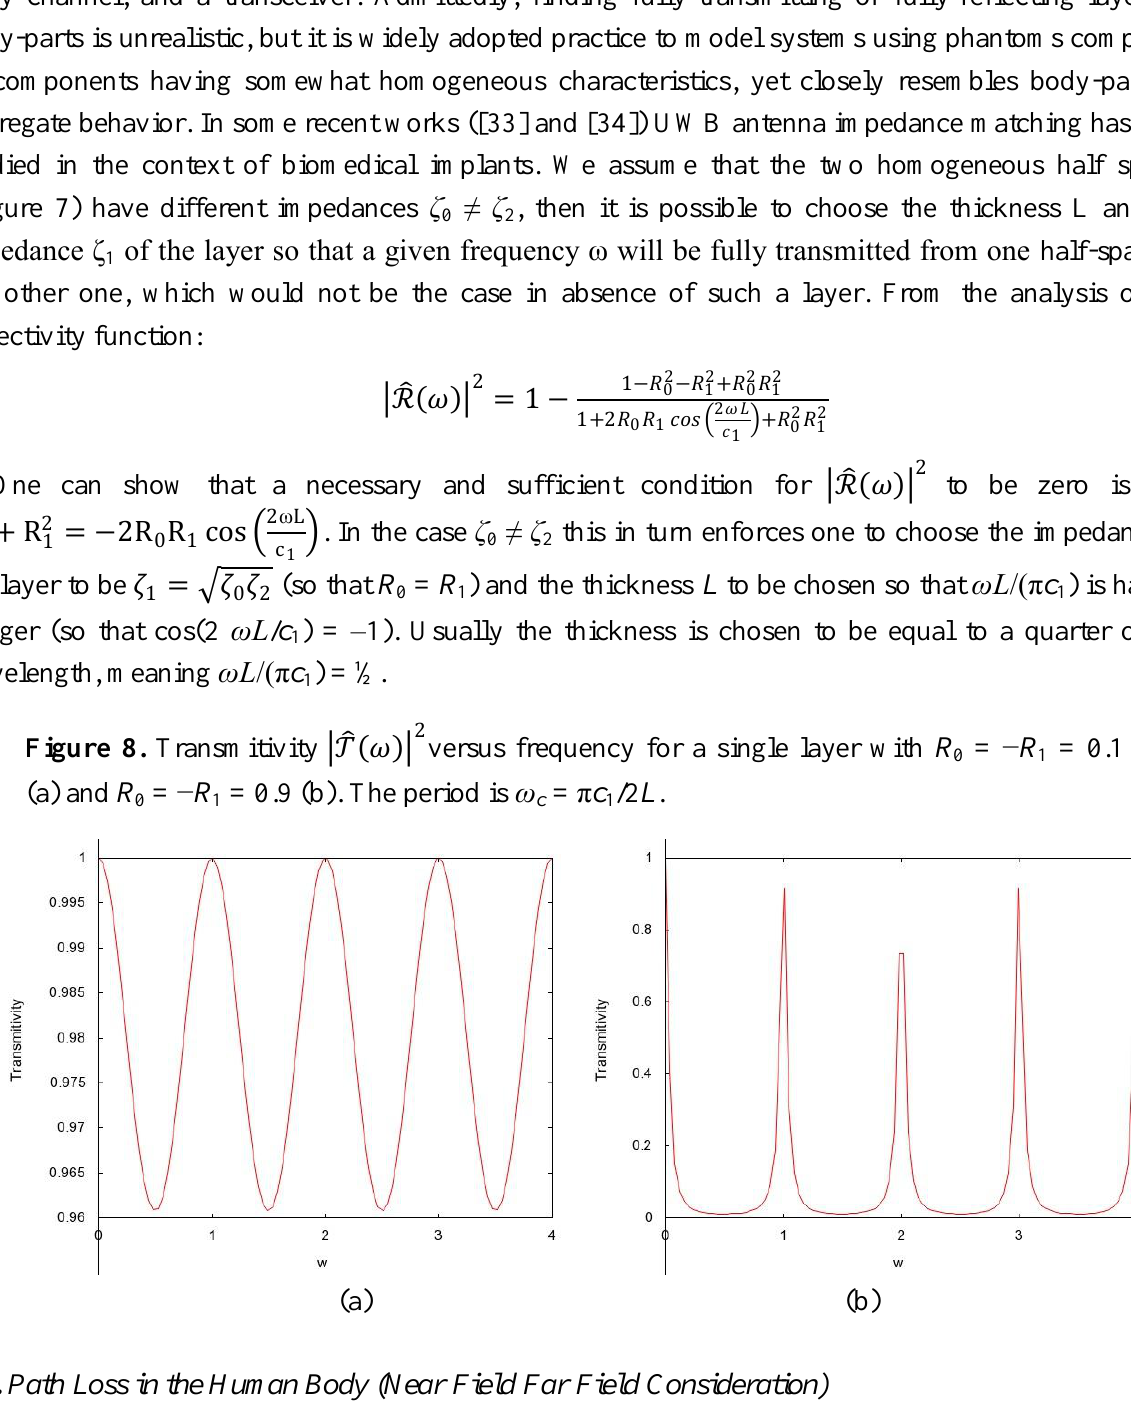
= − R = 0.9 (b). The period is ω 0 1